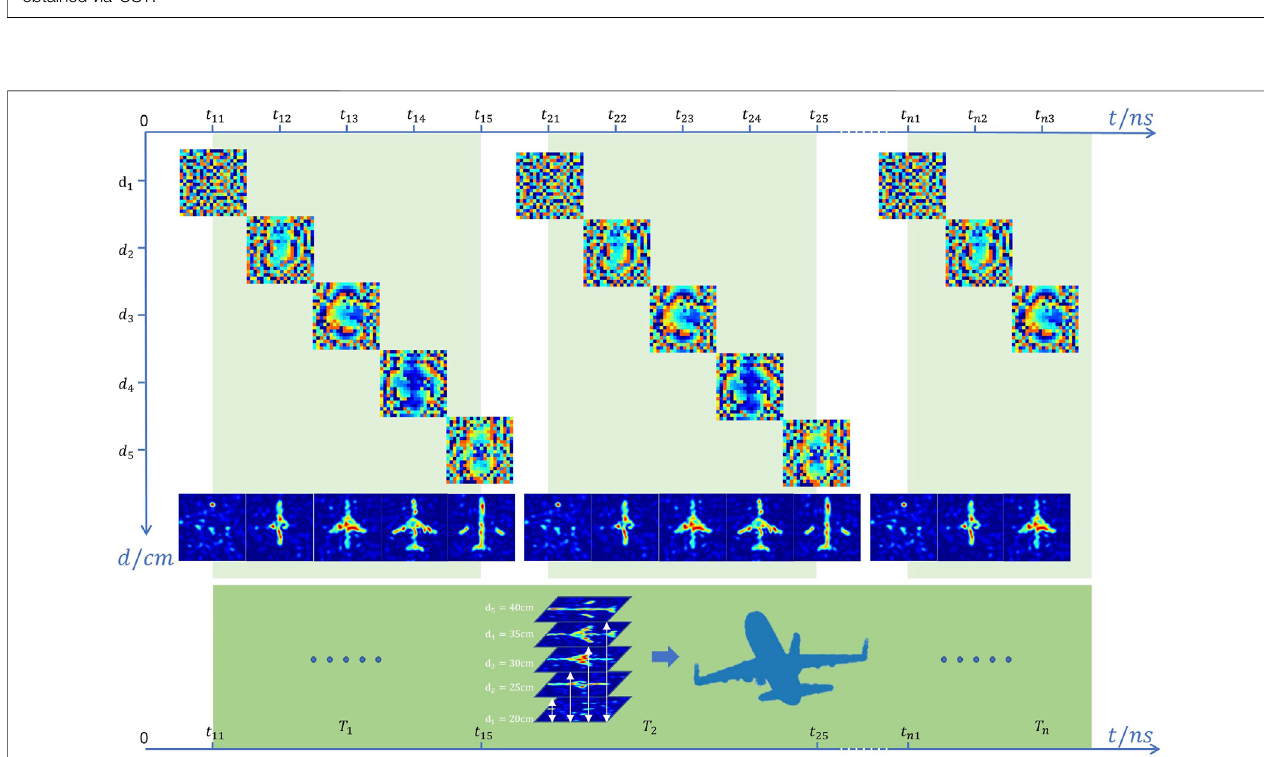
FIGURE 6 | Time – distance division of 3D imaging system.